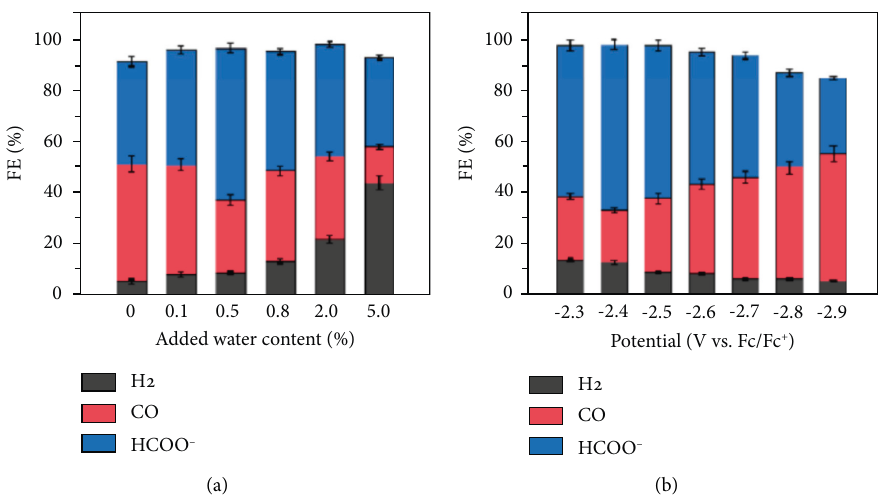
Figure 8: (a) Distribution of CO 2 reduction products in DMF (0.1 M Bu 4 NPF 6 ) as a function of water content at a constant potential of − (blue bar) formation as a function of potential in DMF − 2.5V Fc/Fc + . (b) Faradaic efficiency for H 2 (black bar), CO (red bar), and HCOO (0.1 M Bu 4 NPF 6 ) with 0.5 vol% water from [62] under the terms of the Creative Commons CC BY license.